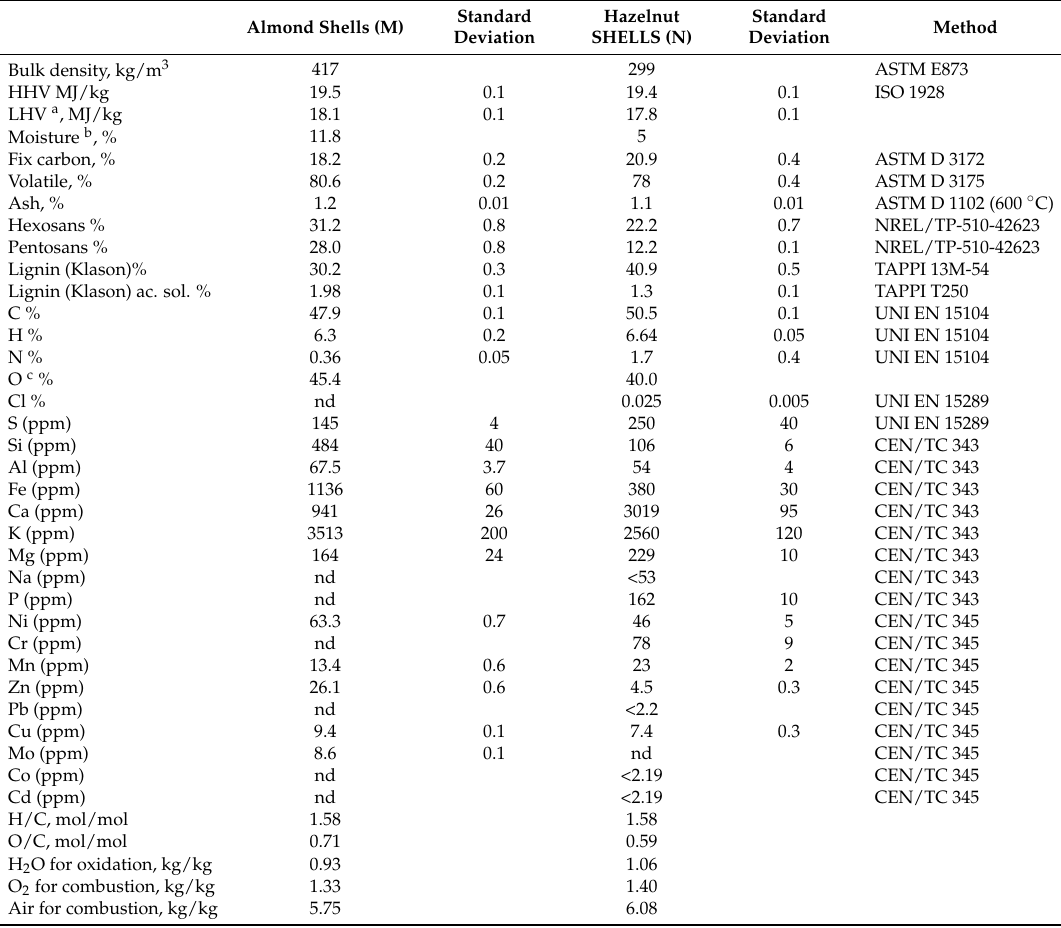
Table 1. Characteristics and properties of the